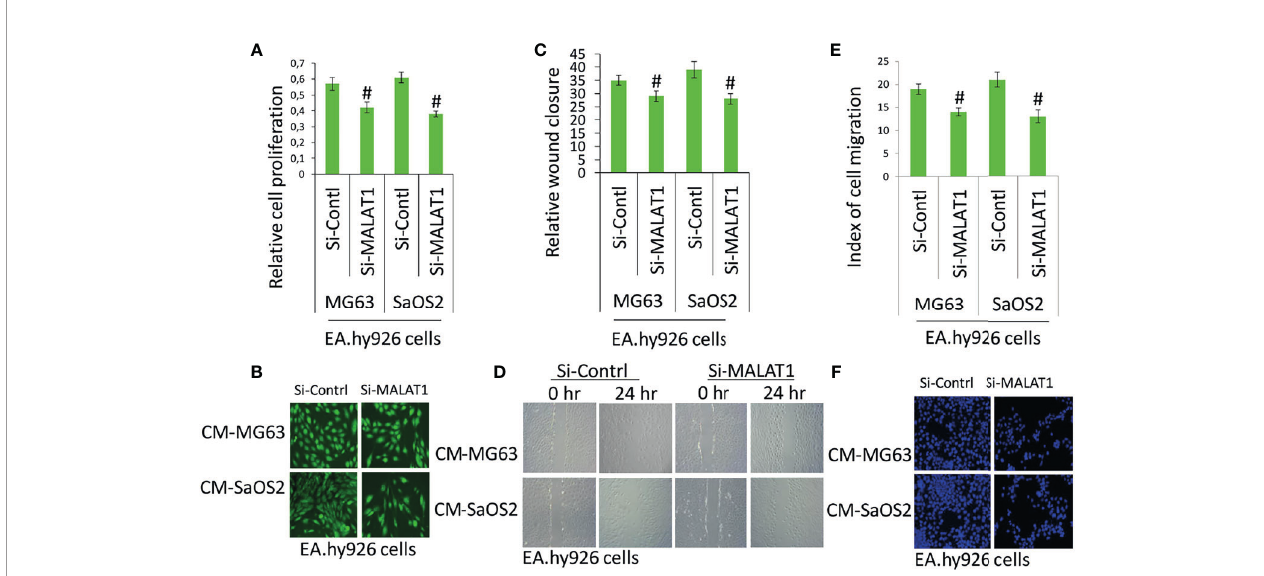
FIGURE 2 | Knockdown of MALAT1 in OS decreased endothelial cell proliferation and migration. After transfection of si-MALAT1 or si-control in MG63 and SaOS2 cells, the conditioned medium was prepared. EA.hy926 cells were exposed with the prepared conditioned medium and cell proliferation and migration was analyzed. (A) EA.hy926 cell proliferation was analyzed my MTT assay, and (B) cell morphology was analyzed by FDA staining after 24 h of treatment. (C) Similarly, scratch wound assay was performed and analyzed relative to wound closure and (D) representative images of wound healing assay. (E) Index of cell migration was analyzed by Boyden chamber assay and (F) shows representative image of DAPI staining of migrated cells. Number sign indicates signi fi cant decrease compared with